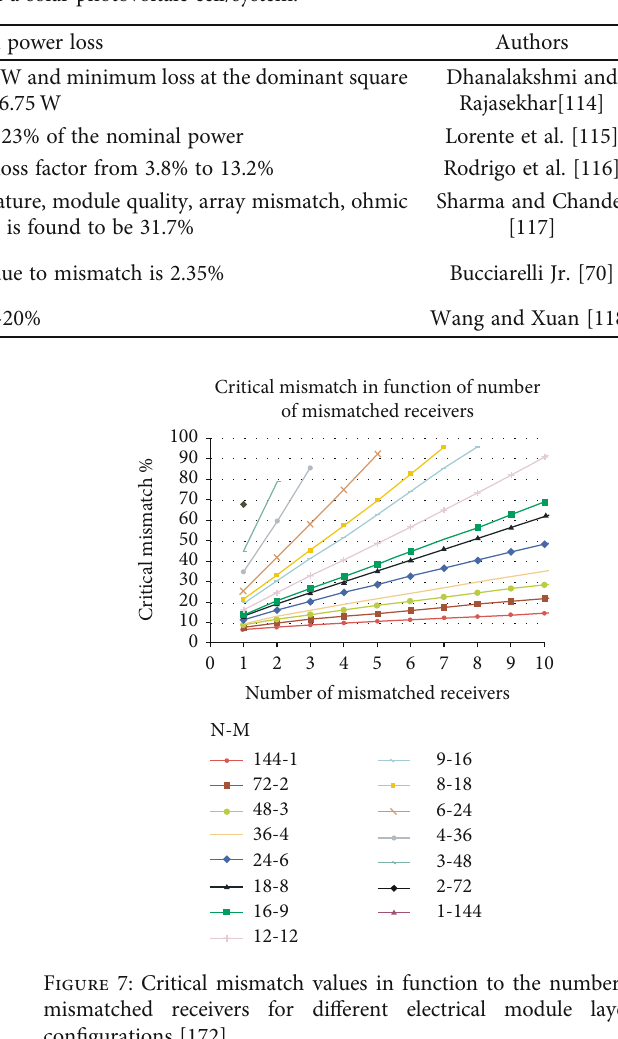
Table 1: Mismatch losses in a solar photovoltaic cell/system.